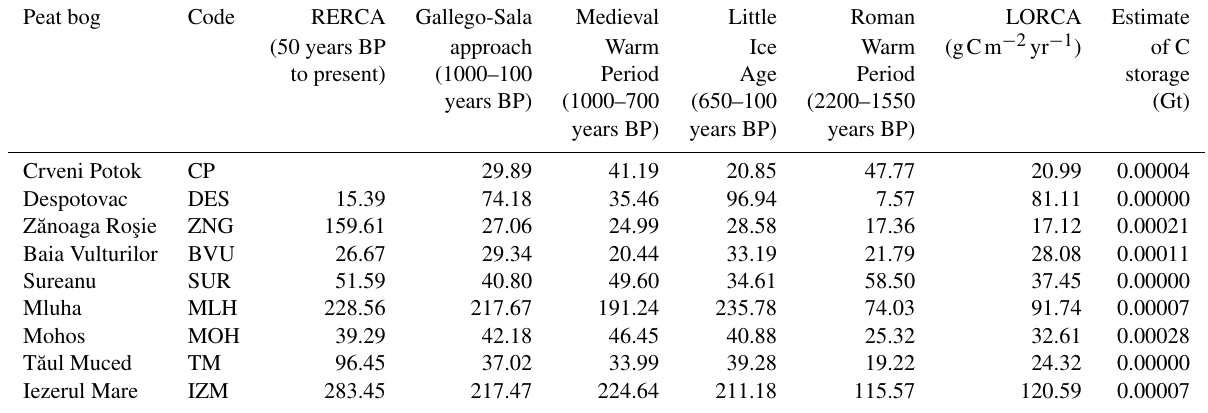
Table 2. Average carbon accumulation rates for a selection of time periods (in gCm − 2 yr − 1 ). Also displayed are the LORCA values and an estimate of carbon storage. See the text for